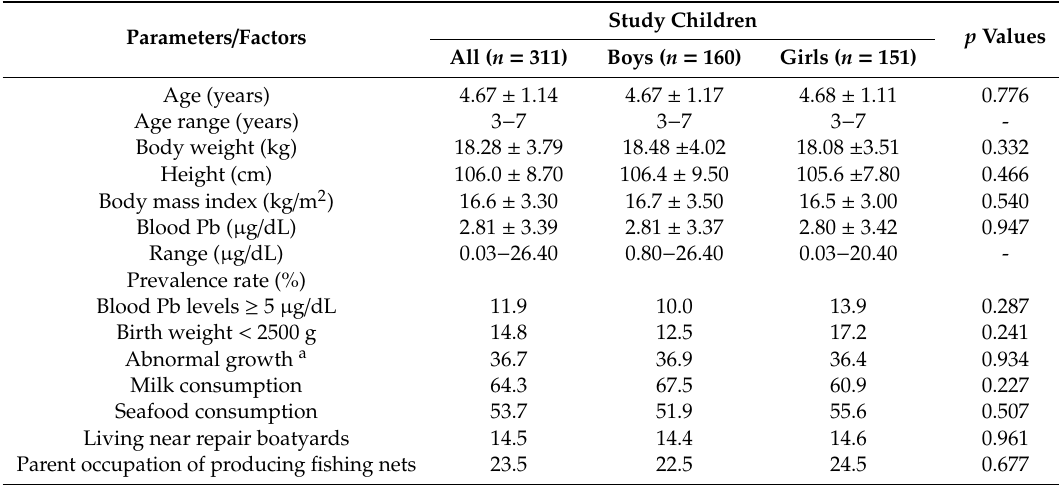
Table 1. Descriptive characteristics of study